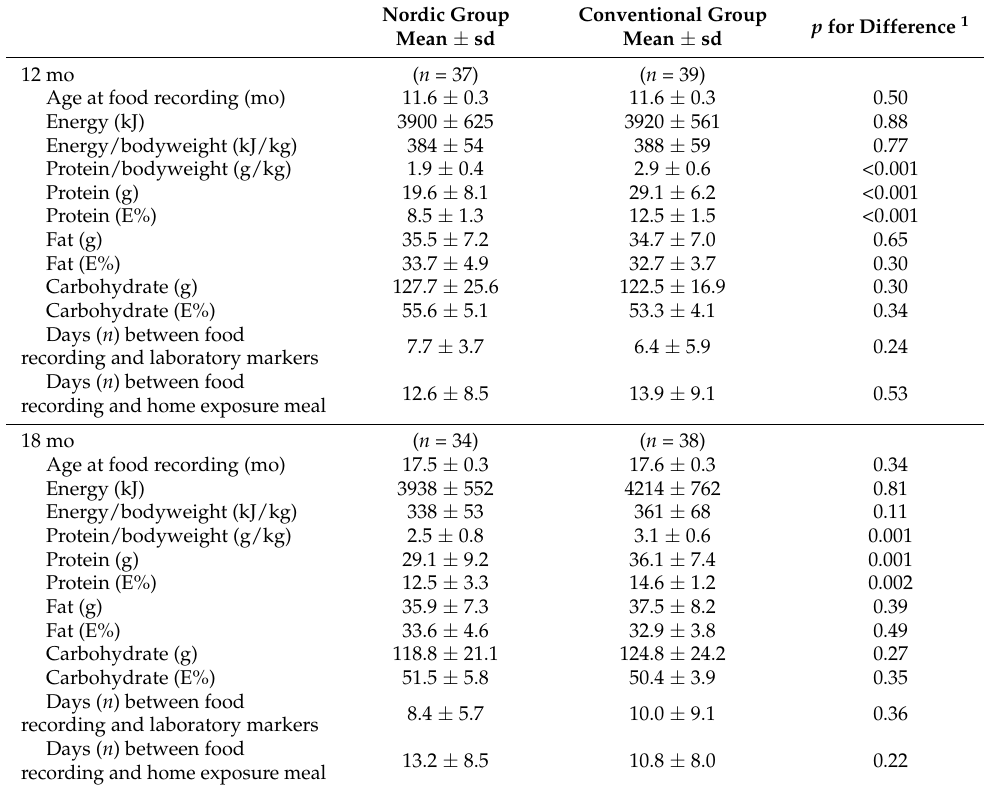
Table 4. Daily mean intake of energy and macronutrients at the 12 and 18 mo 5-day dietary registrations. Nordic Group Mean ±